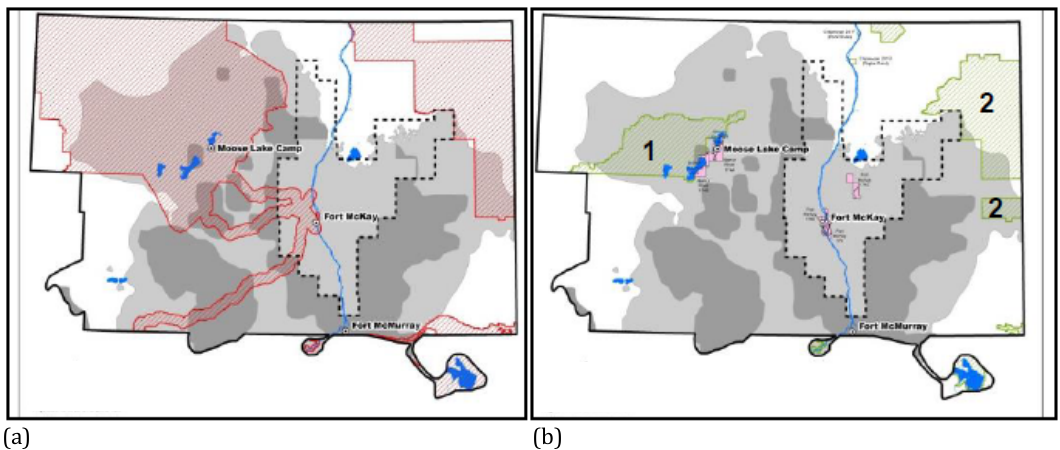
Figure 1: Requested conservation areas (a) vs. granted conservation areas